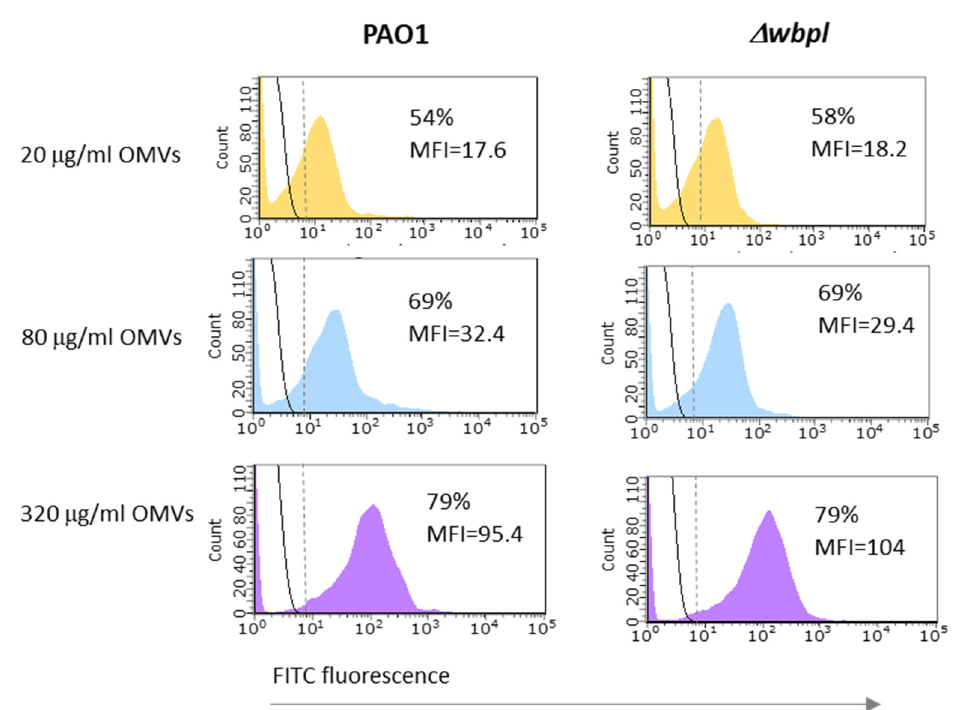
Figure 4. The association of OMVs to P. aeruginosa cells determined by the flow cytometry technique. The experiment was carried out on OMVs derived from PAO1. Bacteria were incubated with FITC-OMVs for 3 h at 37 °C with agitation (200 rpm). The fluorescence intensities of OMVs-associated bacteria are shown as coloured histograms, whereas control bacteria by black solid lines. Calculated percentages of OMV-associated cells include cells separated by a vertical dashed line. Data are expressed as mean fluorescent intensity (MFI) from a representative experiment.